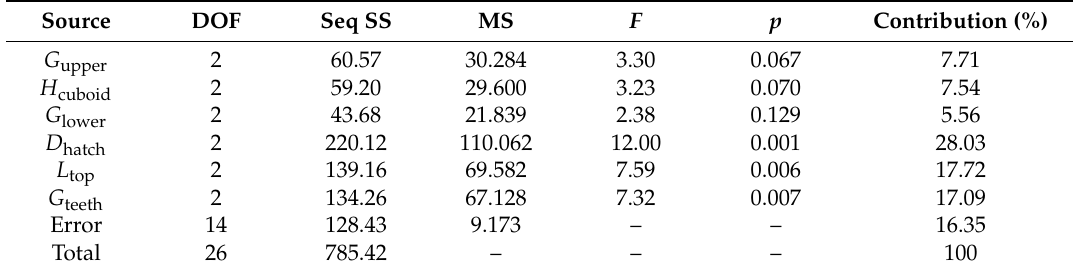
Table 6. ANOVA for warp. R 2 =